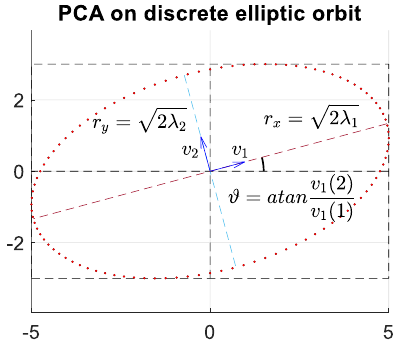
Fig. 7. PCA on ideal elliptic orbit (synthetic data).